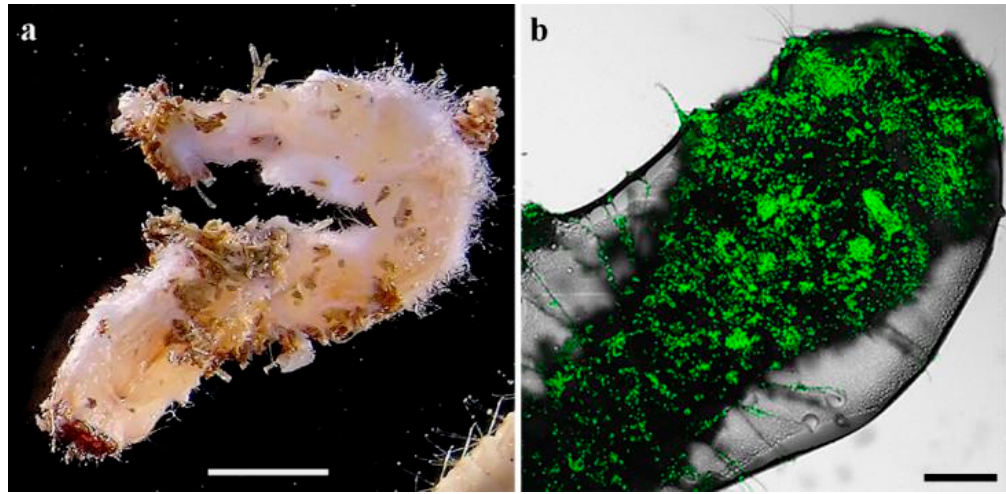
Figure 3. C. tenebrionis larvae infected by Mb7-GFP, 14 days after larval release in the microcosms: ( a ) larva found in a twig; ( b ) larva covered with conidia. Scale bar = 5 mm ( a ) and 0.2 mm ( b ).